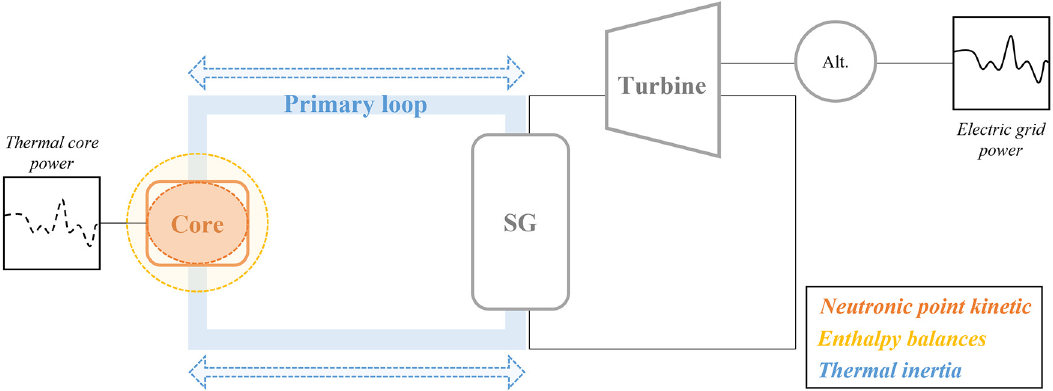
Fig. 6. Diagram of the simpli fi ed modelling of a 1300 MW PWR